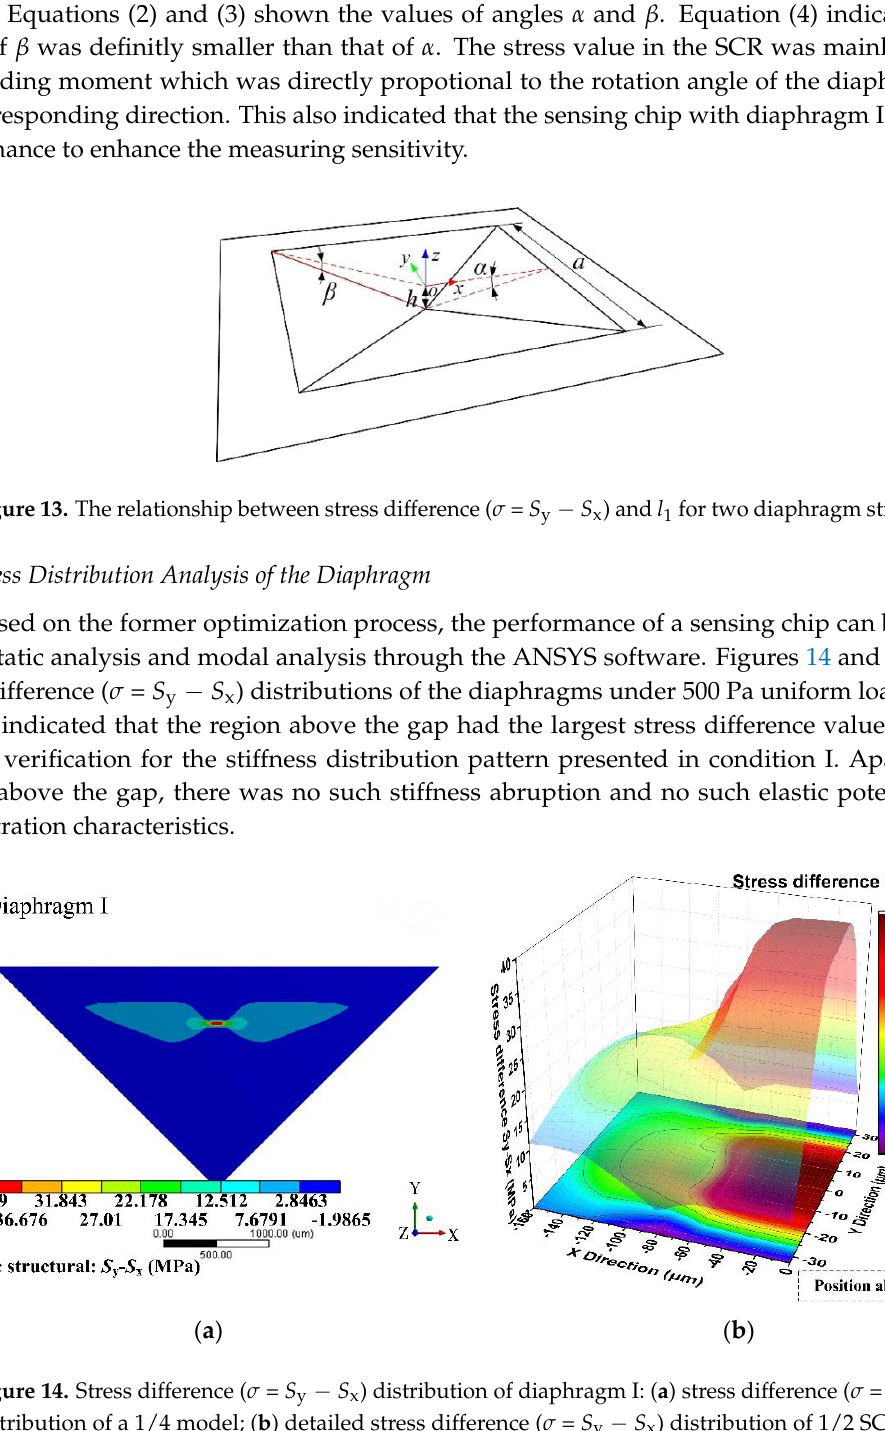
( b ) Figure 14. Stress difference ( σ = S y − S x ) distribution of diaphragm I: ( a ) stress difference ( σ = S y − S x ) distribution of a 1/4 model; ( b ) detailed stress difference ( σ = S y − S x ) distribution of 1/2 SCR.